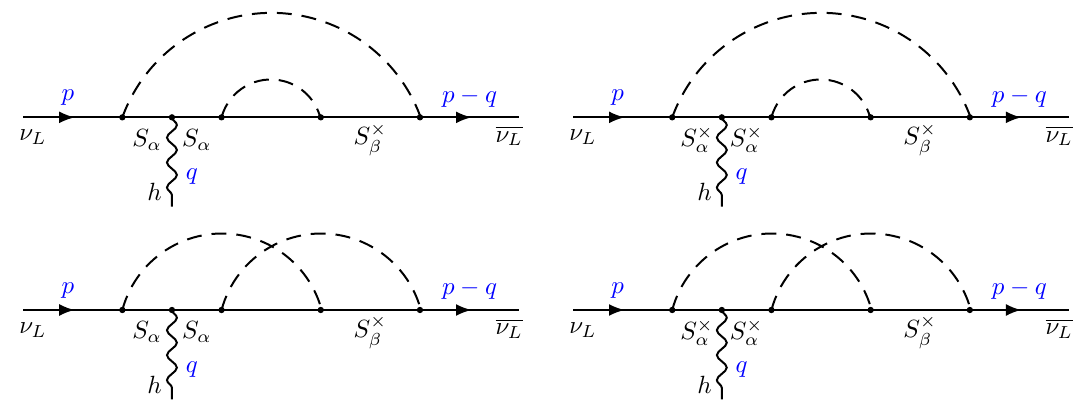
Figure 9 . Two-loop self-energy diagrams for the light leptons with an h insertion on the sterile neutrino (cid:11) propagator, corresponding to the two lower diagrams in (cid:12)gure 3. Similar diagrams with the h insertion on the sterile neutrino (cid:12) propagator are also to be included, along with insertions on the Higgs propagator and Yukawa vertices [2]. The diagrams with two S (cid:11) propagators have an h (cid:23) R (cid:23) c vertex while those with two S (cid:2) propagators have an h (cid:23) c (cid:23) R vertex, as seen from (2.23) (cid:11) R R and (cid:12)gure